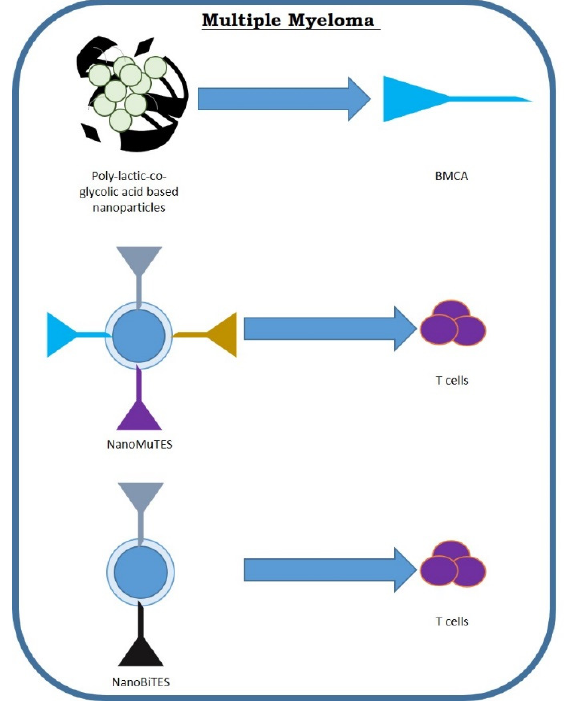
Figure 3. Possible targets of nanoparticles in the treatment of myeloma cells.